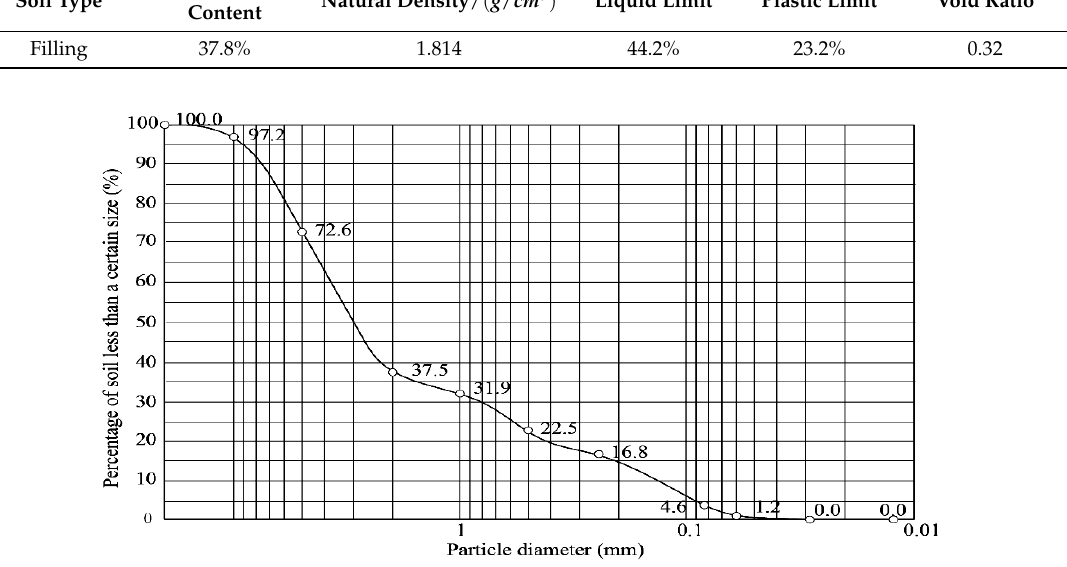
Figure 7. Particle size distribution curve of injected soil.